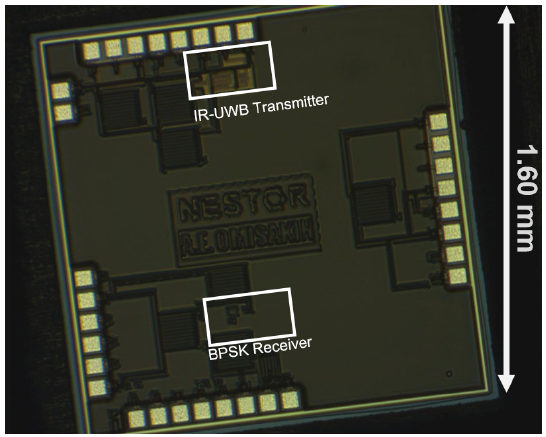
Figure 9. Micro-graph of the fabricated transceiver